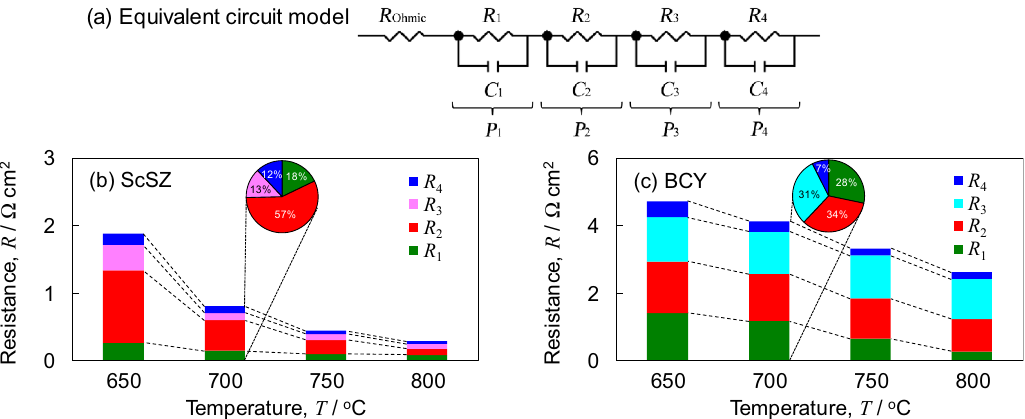
Figure 5. ( a ) Equivalent circuit model with a series connection of resistance ( R ) and four parallel resistance– capacitance ( RC ) elements. ( b , c ) Temperature dependence of polarization resistances in H 2 :H 2 O:N 2 = 20:3:77 vol.% (anode) and O 2 :H 2 O:N 2 = 20:3:77 vol.% (cathode) for SOFCs supported on ScSZ electrolyte and PCFCs supported on BCY electrolyte. The pie chart depict the ratios of the polarization resistance at 700 °C.